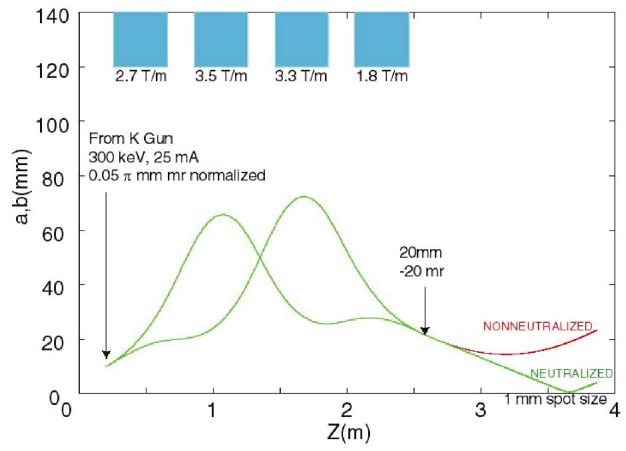
FIG. 2. (Color) Final-focus lattice for ballistically neutralized